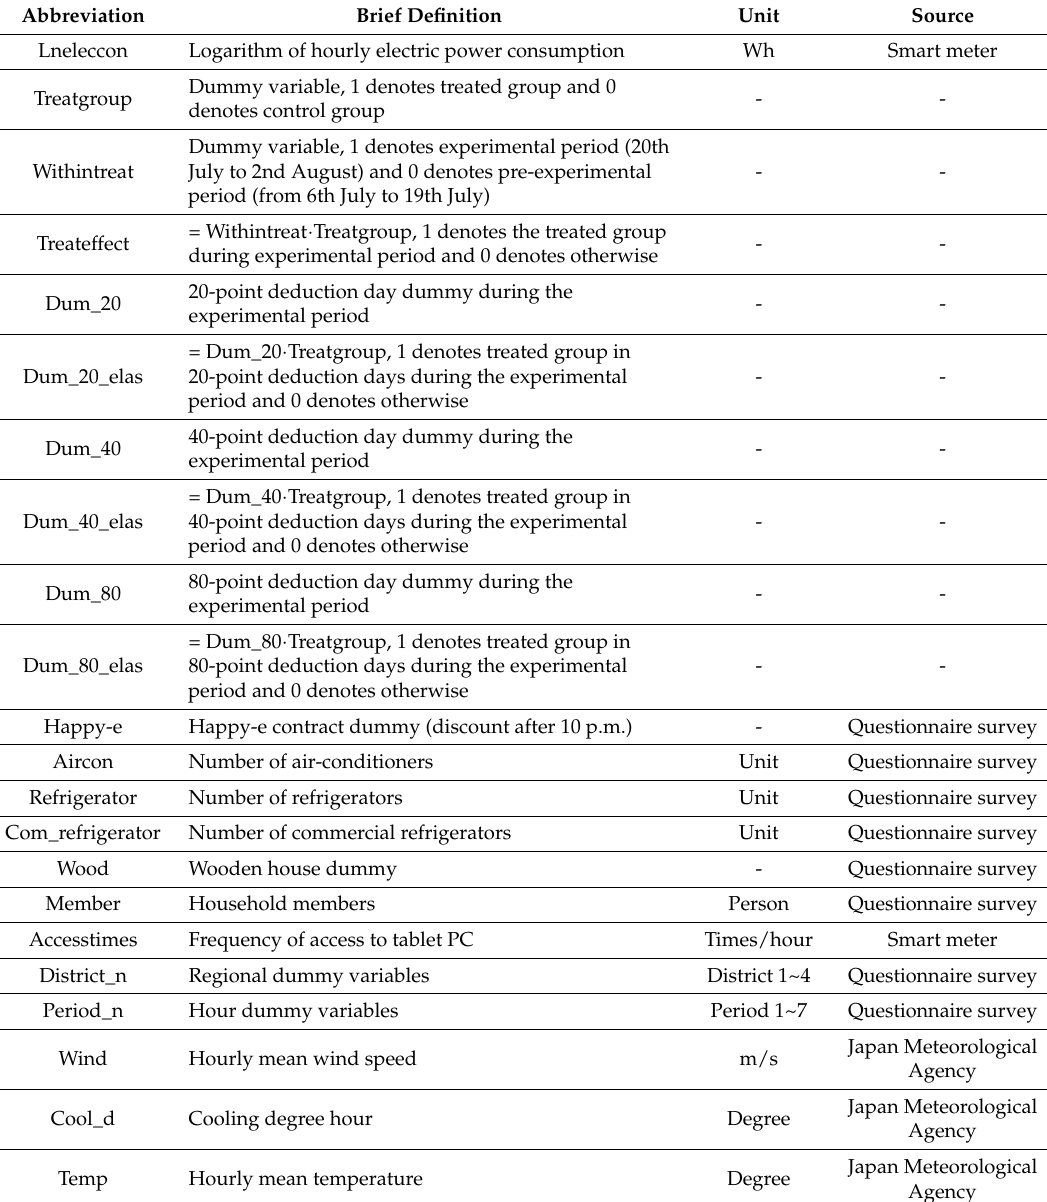
Table 1. Description of the outcome variable, treatment variables and control variables in the